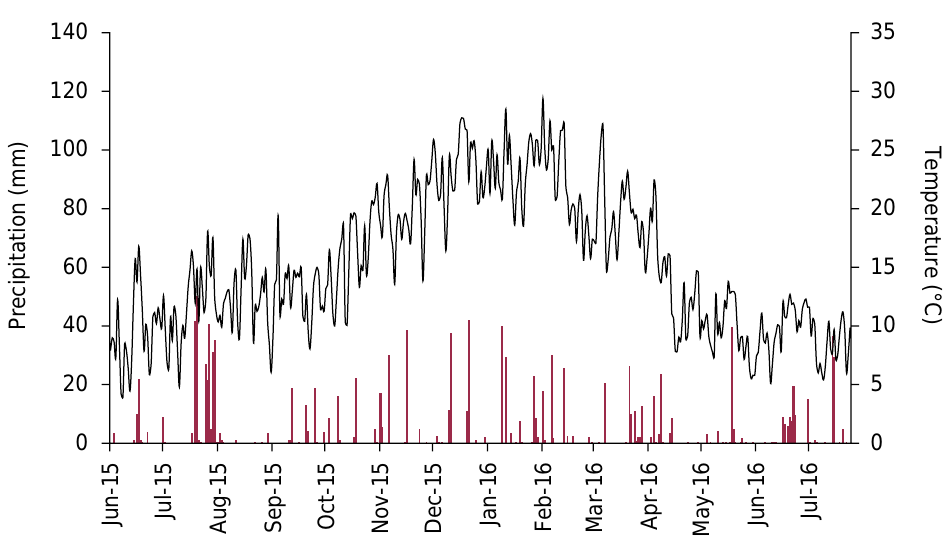
Figure 1. Precipitation and air temperature registered during the simulation period in the studied